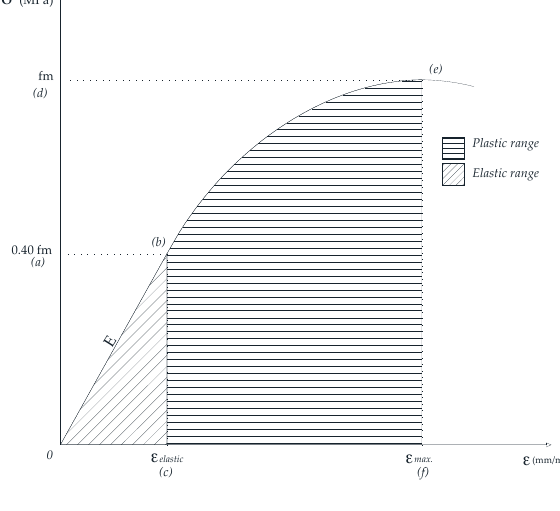
Figure 1.  -  curve diagram. Figure 1. σ - ε curve